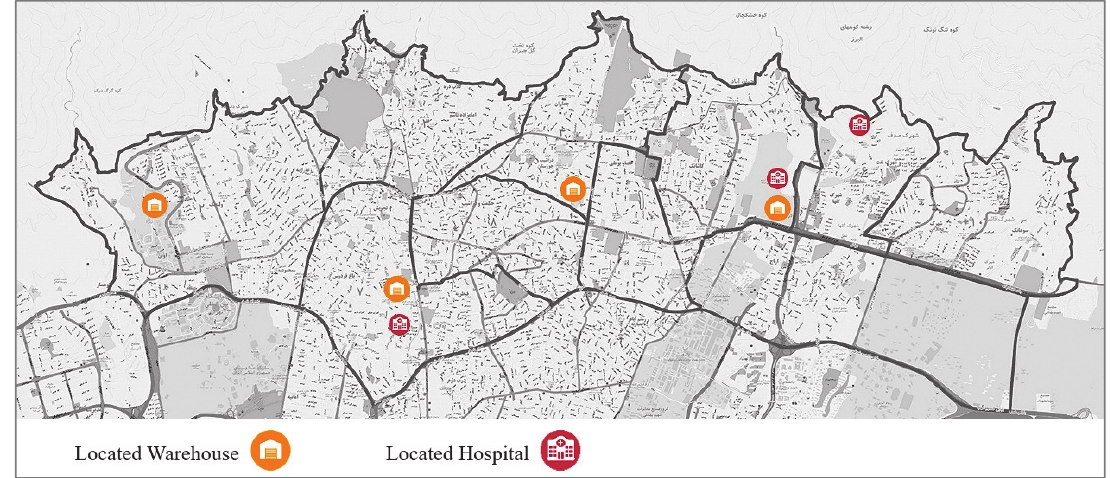
Fig. 2. The location of hospitals and warehouses in Region one